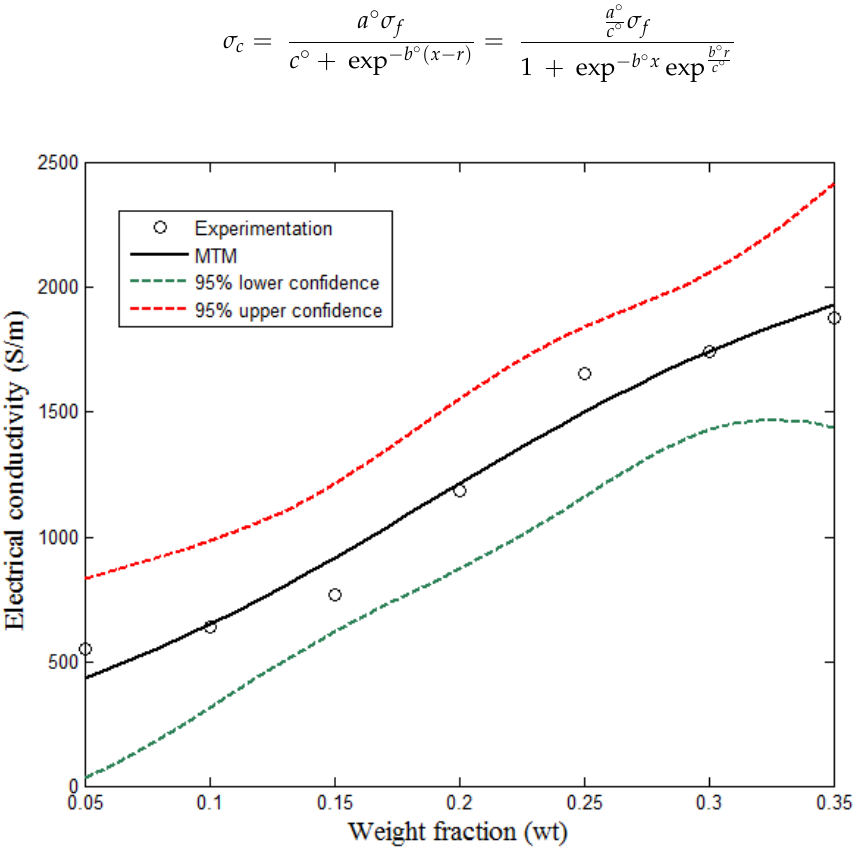
Figure 12. Comparison of experimental measurements with MTM.